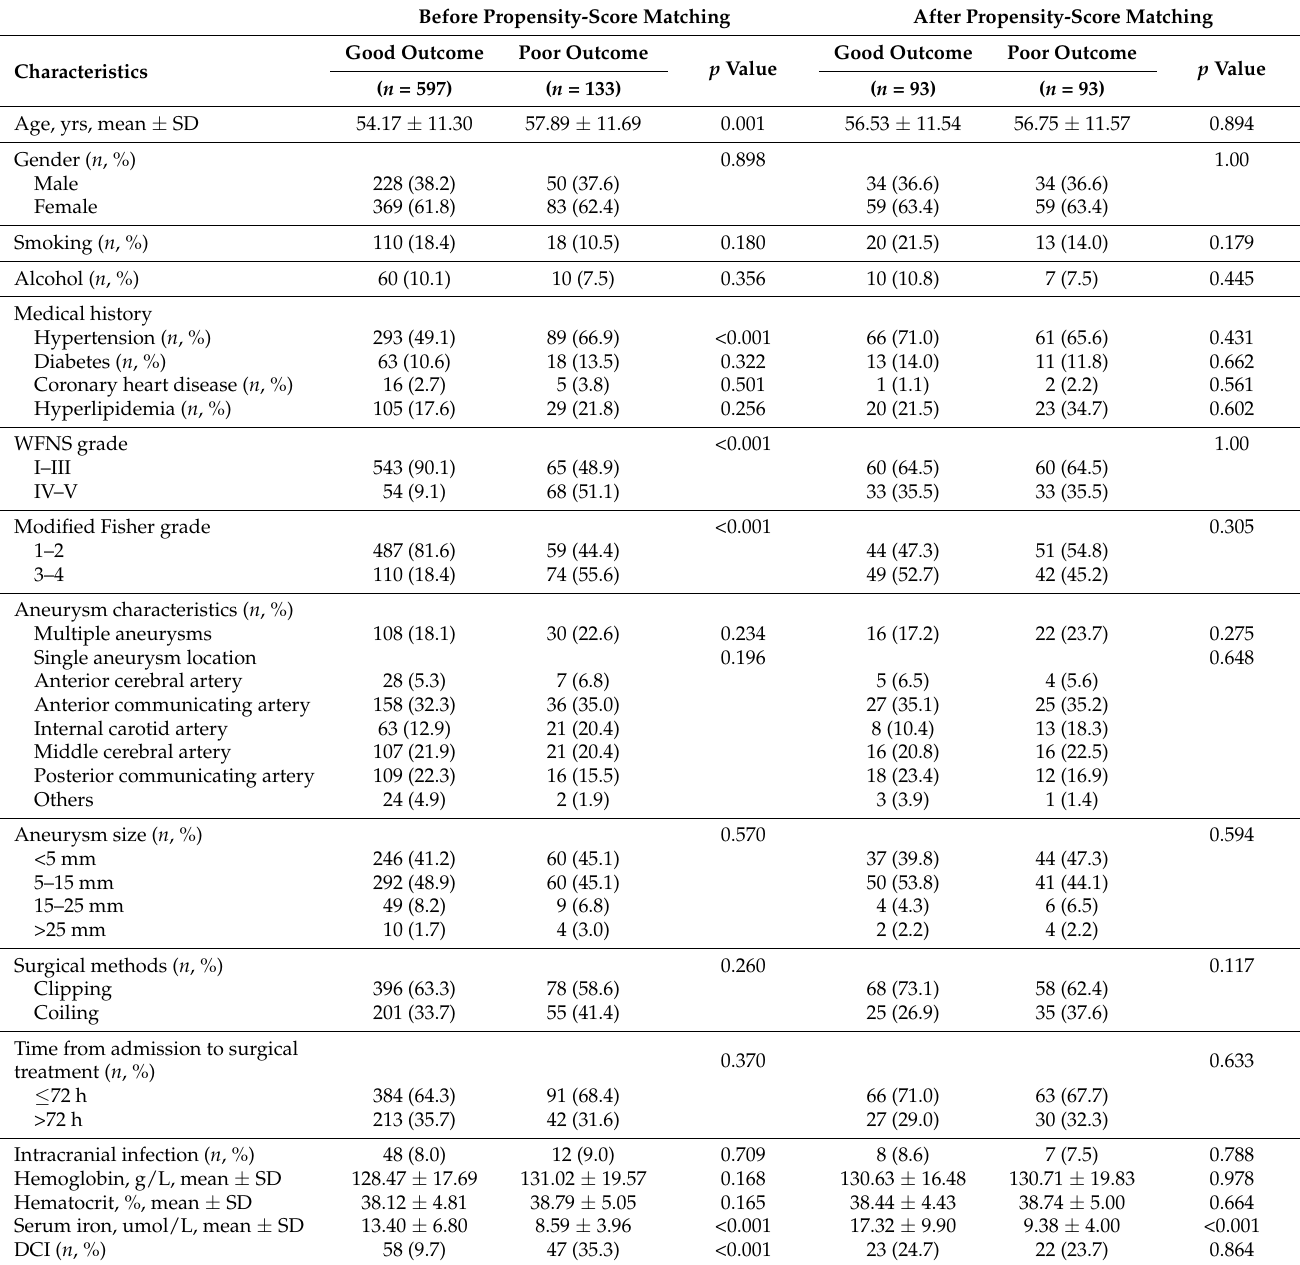
Table 3. Univariate analysis of association with outcome in aSAH before and after propensity- score